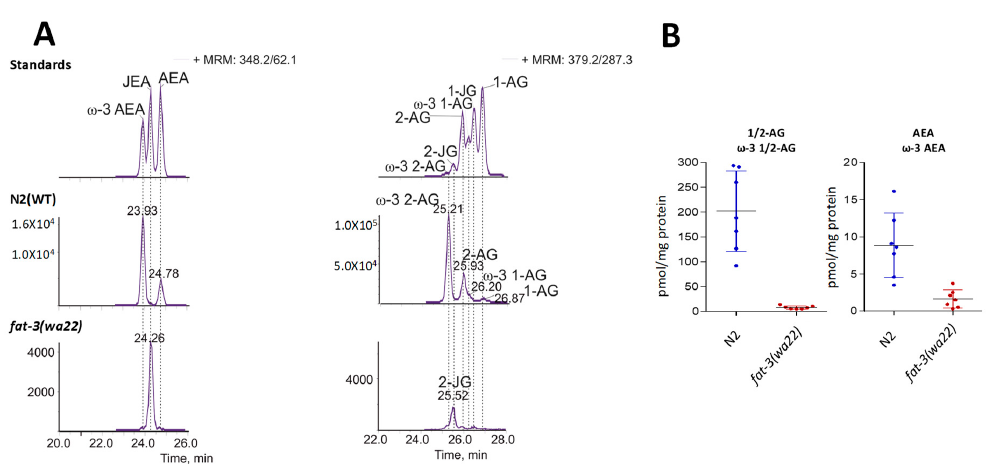
Figure 8. Detection of new EC-like molecules in N2 (WT) and fat-3(wa22) animals. ( A ) LC-MS/MS chromatograms of AA, ω -3 AA and JuA derived EC-like molecules in simultaneously bred N2 (WT) animals and fat-3(wa22) mutants. ( B ) Quantification of the glycerol derived 1/2-AG, ω -3 1/2-AG and 1/2-JG of the ethanolamine-derived AEA, ω -3 AEA and JEA in N2 (WT) and fat-3(wa22) C. elegans by LC-MS/MS. Scatter plots show mean ± SD.